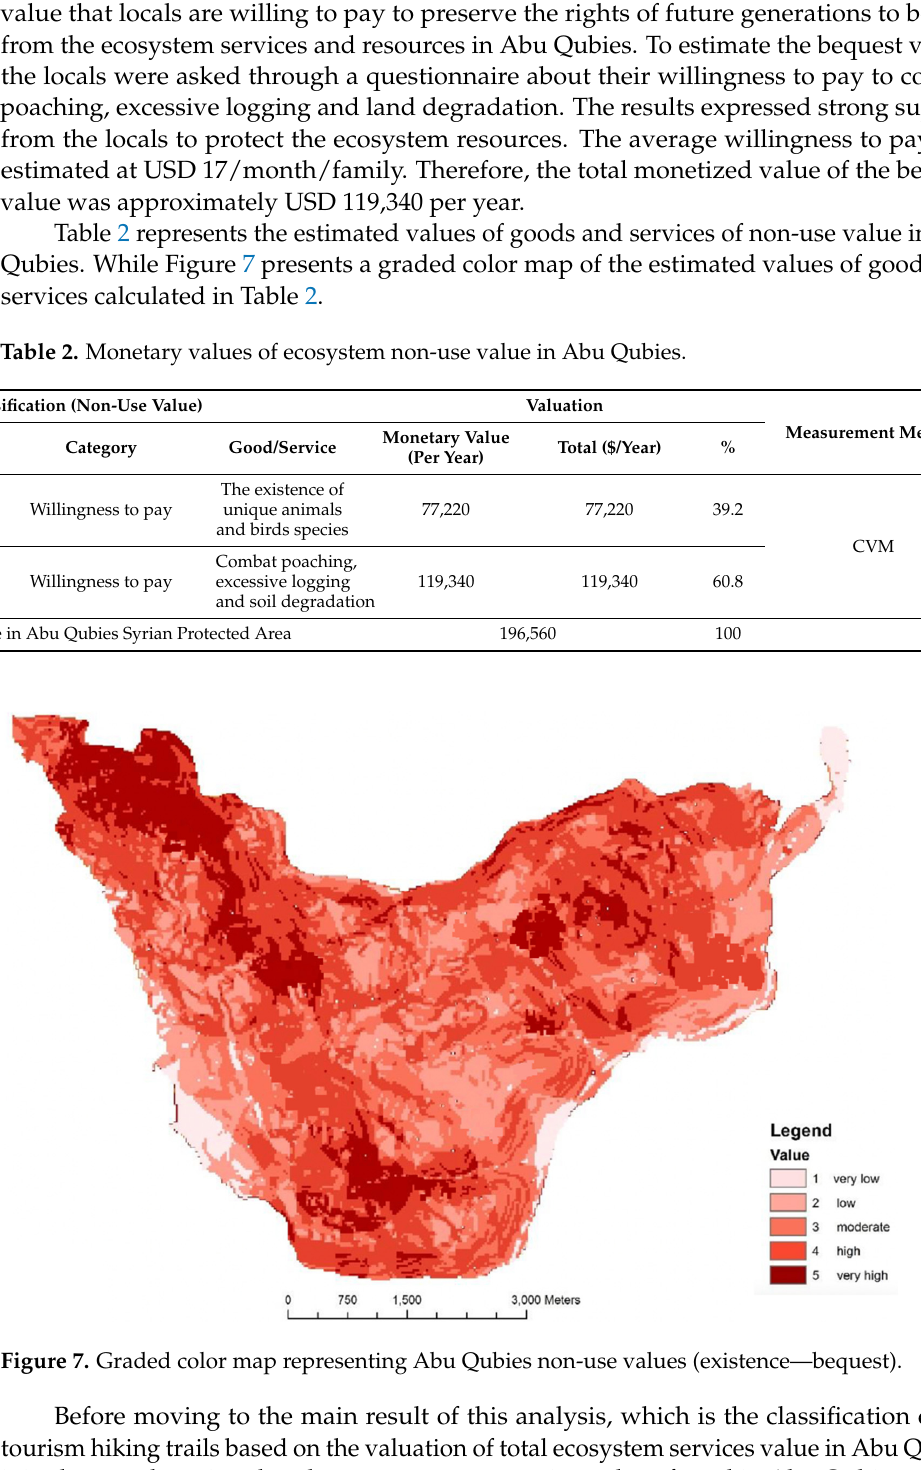
Figure 8. Change of vegetation in Abu Qubies protected area in 2019 and 2021.